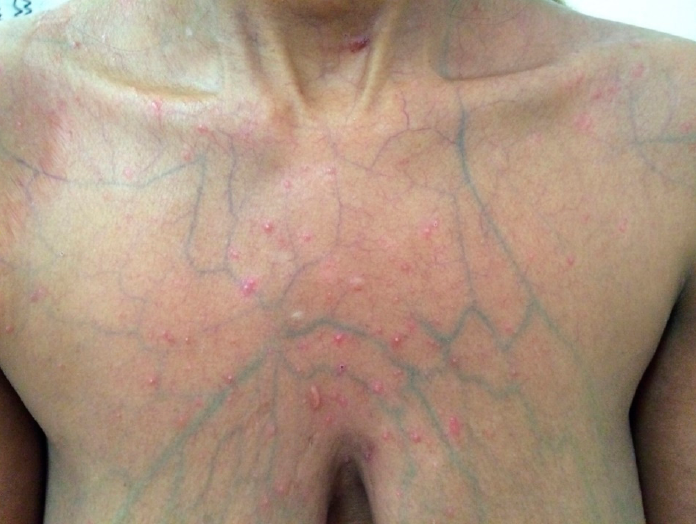
Figure 3. Topical-induced skin atrophy, telangiectasia and acne.